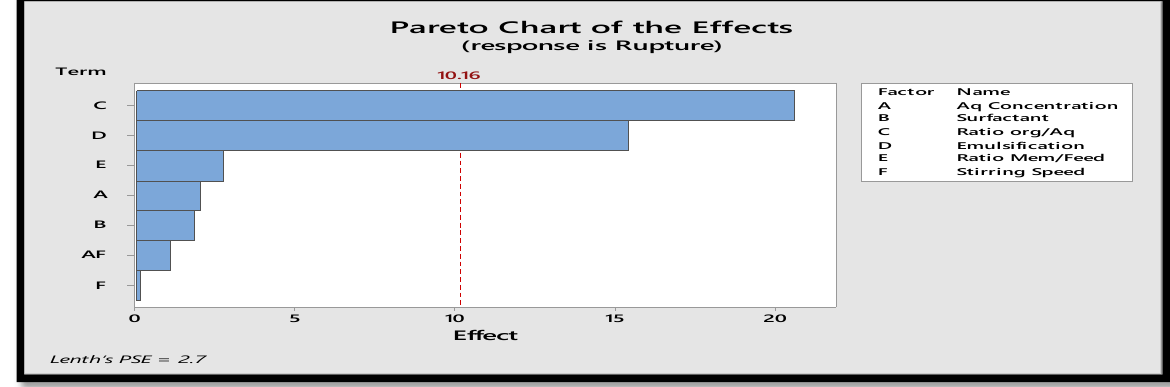
FIG. 1. PARETO CHART OF EFFECTS FOR RUPTURE AS RESPONSE